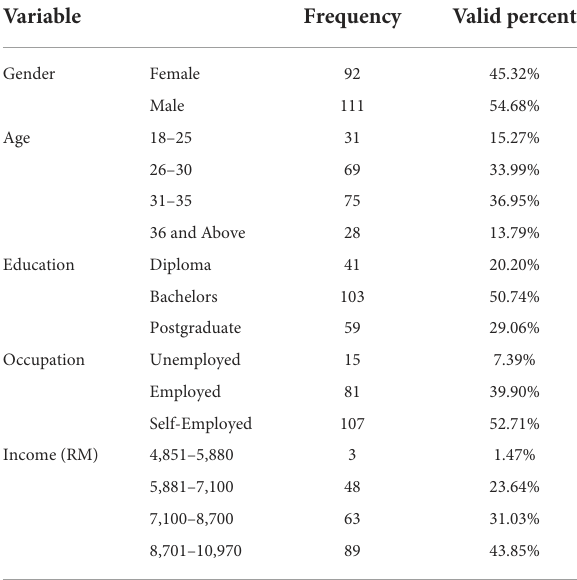
TABLE 1 Demographic characteristics of